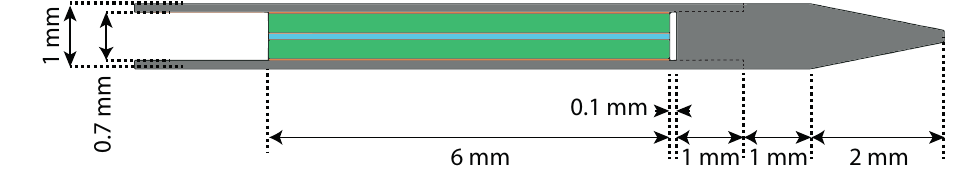
Figure 5. Geometry and dimensions of the Invar capillary concept, showing Invar parts in grey, a fused quartz ferrule in green, an optical fiber in blue and glue layers in orange. The press-fit connection between the needle tip and the stylet tube is shown as a dashed line. The aim for the FPI-cavity length was